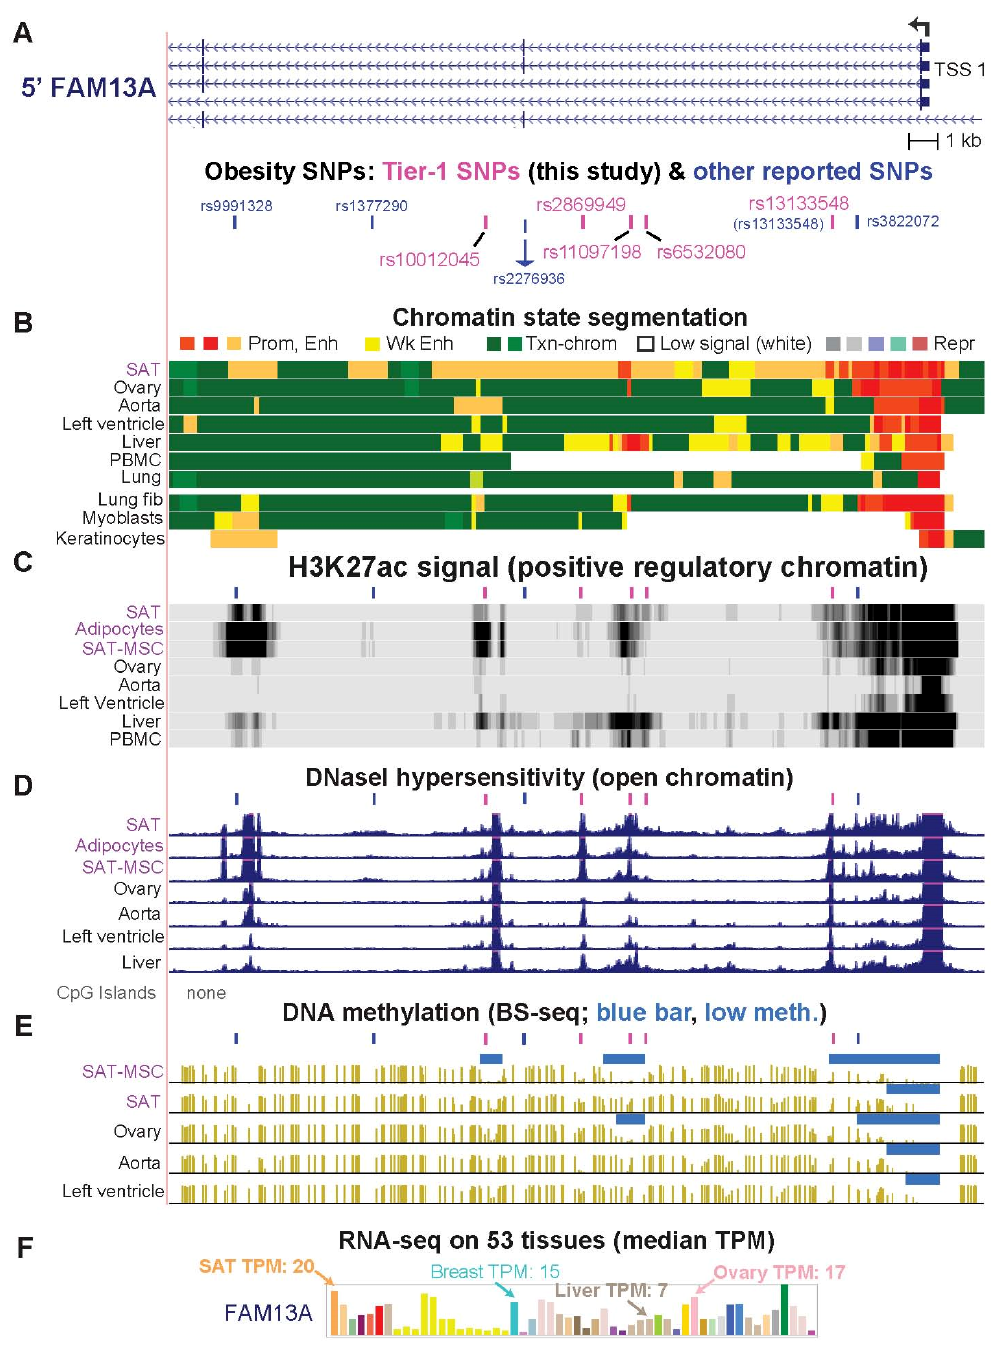
Figure 3. One of the previously highlighted obesity-related SNPs in FAM13A (rs13133548) has optimal epigenetic features to be an obesity-risk regulatory SNP. ( A ) A 37-kb region (chr4:89,710,207–89,746,974) overlapping five of the six Tier-1 SNPs (pink bars) as well as four other SNPs that had been described as regulatory SNP candidates from obesity GWAS (blue bars); rs13133548 is the one Tier-1 SNP that was previously described. ( B – E ) Chromatin state segmentation, H3K27ac, DHS, and bisulfite-seq profiles as in Figure 2. ( F ) Bar graph of median expression levels for different tissues as in Figure 2. Pink or blue bars above tracks in panels ( C – E ), indicate positions of Tier-1 SNPs and previously highlighted candidates for regulatory SNP, respectively. PBMC, peripheral blood mononuclear cells; SAT-MSC, subcutaneous adipose tissue-derived stem/stromal cells; BS-seq, whole genome bisulfite sequencing; meth, methylation; TPM, transcripts per million.